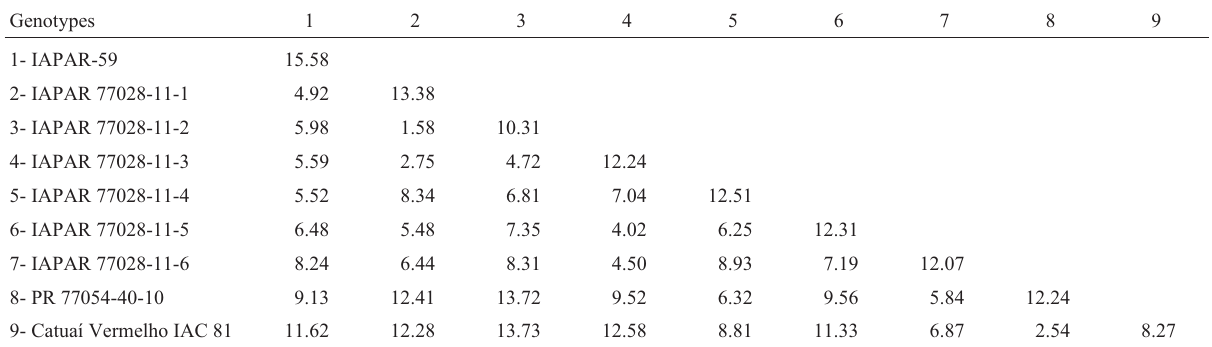
Table 3 - Mean differences of the genetic differentiation among individuals within populations and between pairs of C. arabica populations estimated according to Yeh et al. (1997). Genotypes